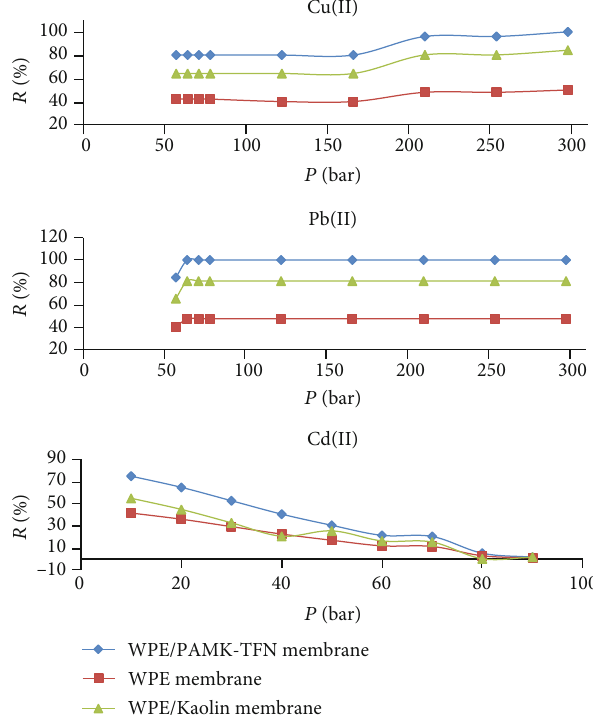
Figure 11: E ff ect of pressure on rejection of the heavy metals fi ltration on the WPS, WPS/kaolin, and WPE/PAMK-TFN